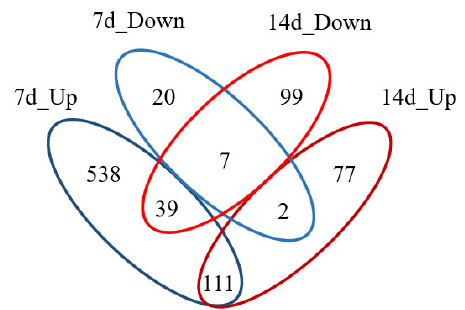
Figure 2. Comparison of DEPs between 14 d and 7 d SMG. From 7 d to 14 d SMG treatment, the expression of 558 DEPs in rat intestinal mucosa returned to the normal levels. Moreover, 111 DEPs were continuously upregulated, and 7 DEPs were continuously downregulated. Note: results of 7 d SMG DEPs were cited from Reference [11].